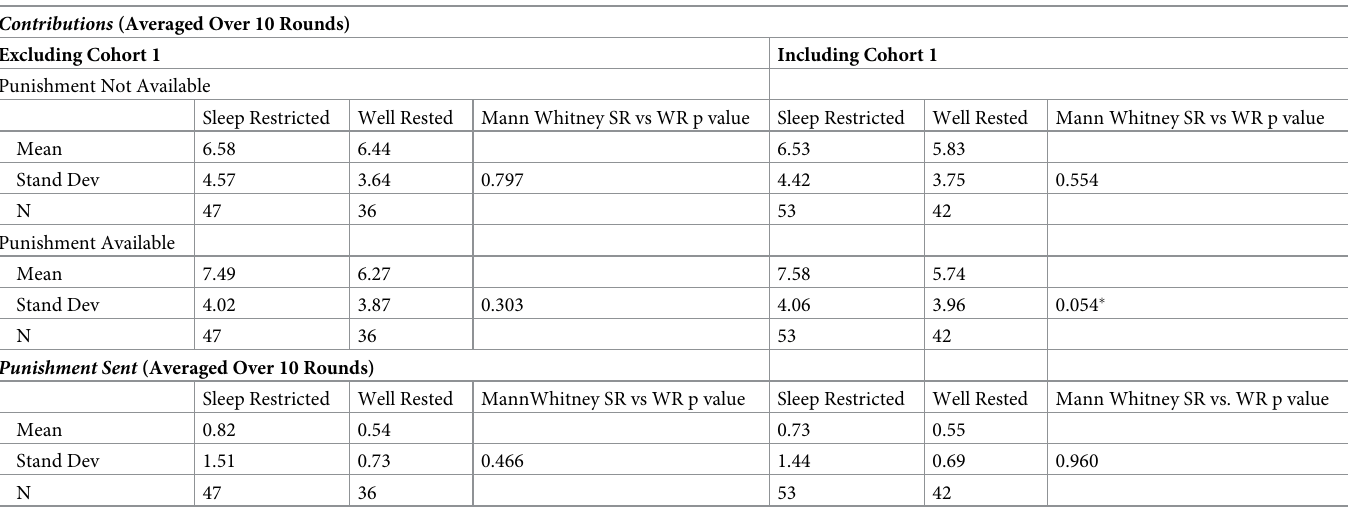
Table 3. Non parametric tests for treatment effects—compliant subjects only a